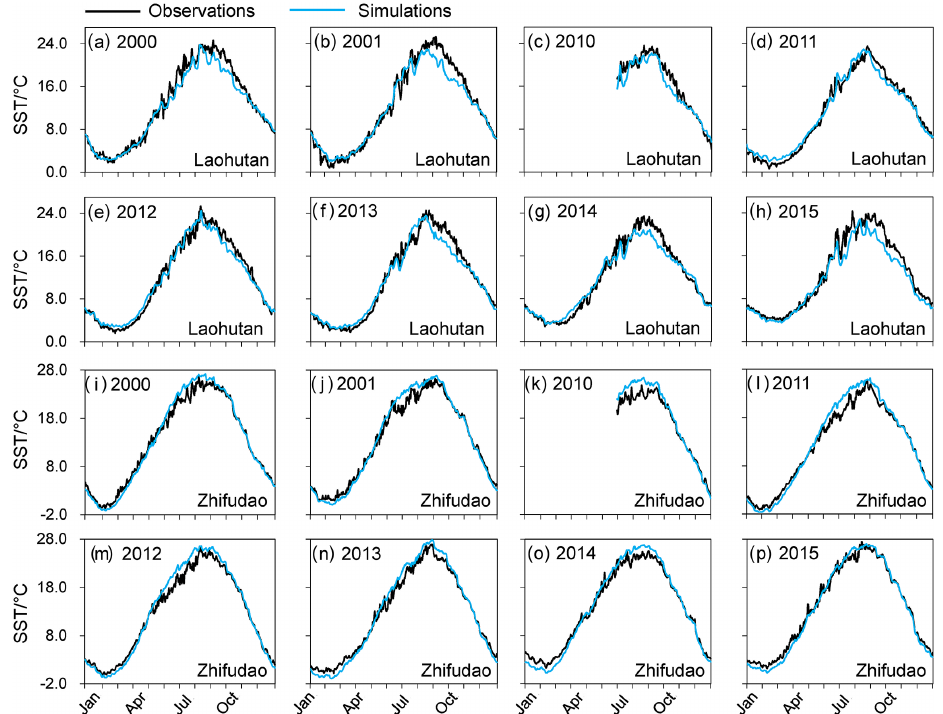
Figure 4. The simulated sea surface temperature (SST) compared with in situ observations at Laohutan, Dalian (a–h) , and Zhifudao,